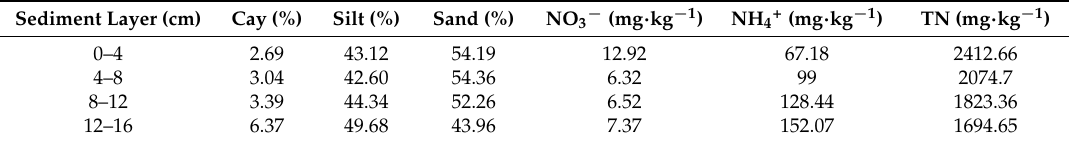
Table 1. Characteristics of sediment used in the simulation